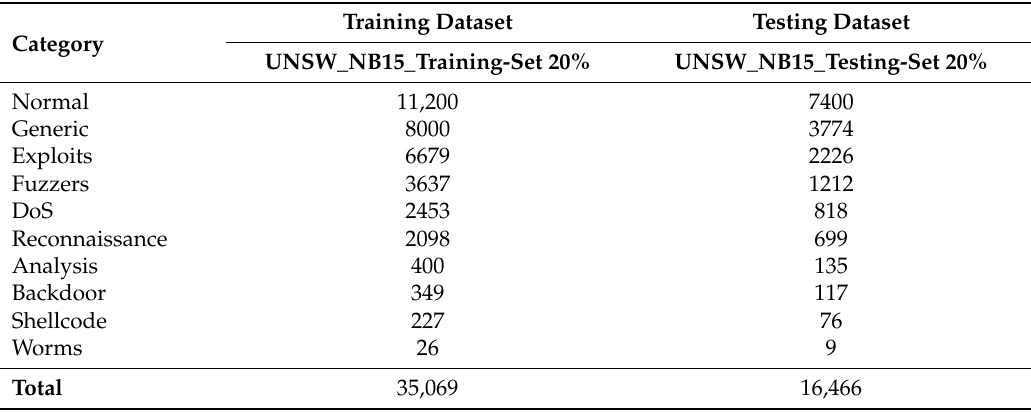
Table 4. The class distribution of the UNSW-NB15